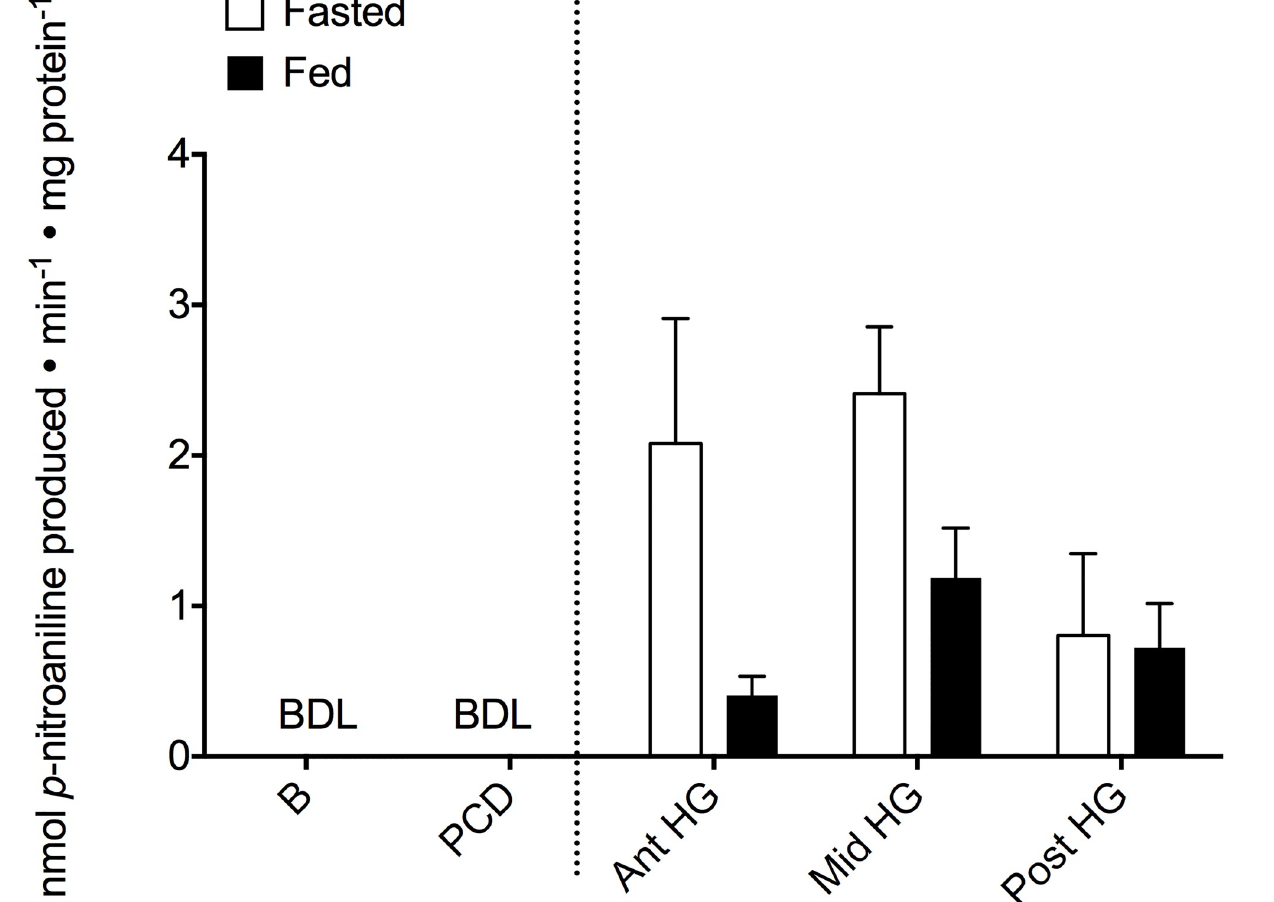
Fig 4. The trypsin activity (nmol p -nitroaniline produced min -1 mg protein -1 ) along the entirety of the Pacific hagfish hindgut does not change with feeding status. Activity was measured in both fasted (white bars) and fed (black bars) hagfish in five locations down the alimentary canal (B— buccal cavity, PCD—pharyngocutaneous duct, Ant HG—anterior hindgut, Mid HG—mid hindgut, Post HG—posterior hindgut). Bars represent means + s.e.m. of 3–8 hagfish. BDL = below the detectable limits of the assay. A Kruskal-Wallis analysis revealed significant differences between the anterior and posterior segments of the tract, thus a 2-way ANOVA to determine effect of feeding and location was conducted in the hindgut only (right of the dotted line). Significance was accepted at α = 0.05.